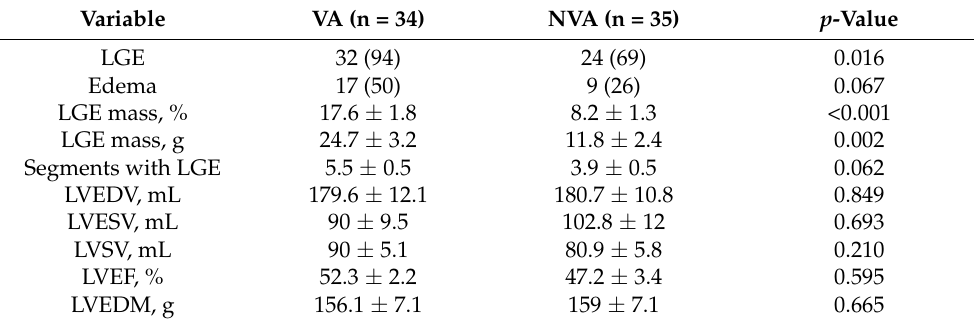
Figure 2. LGE size in % of left ventricular myocardial mass. LGE, late gadolinium enhancement; NVA, non ‐ ventricular arrhythmia; VA, ventricular arrhythmia. Table 2. Cardiac magnetic resonance imaging characteristics. Table 2. Cardiac magnetic resonance imaging